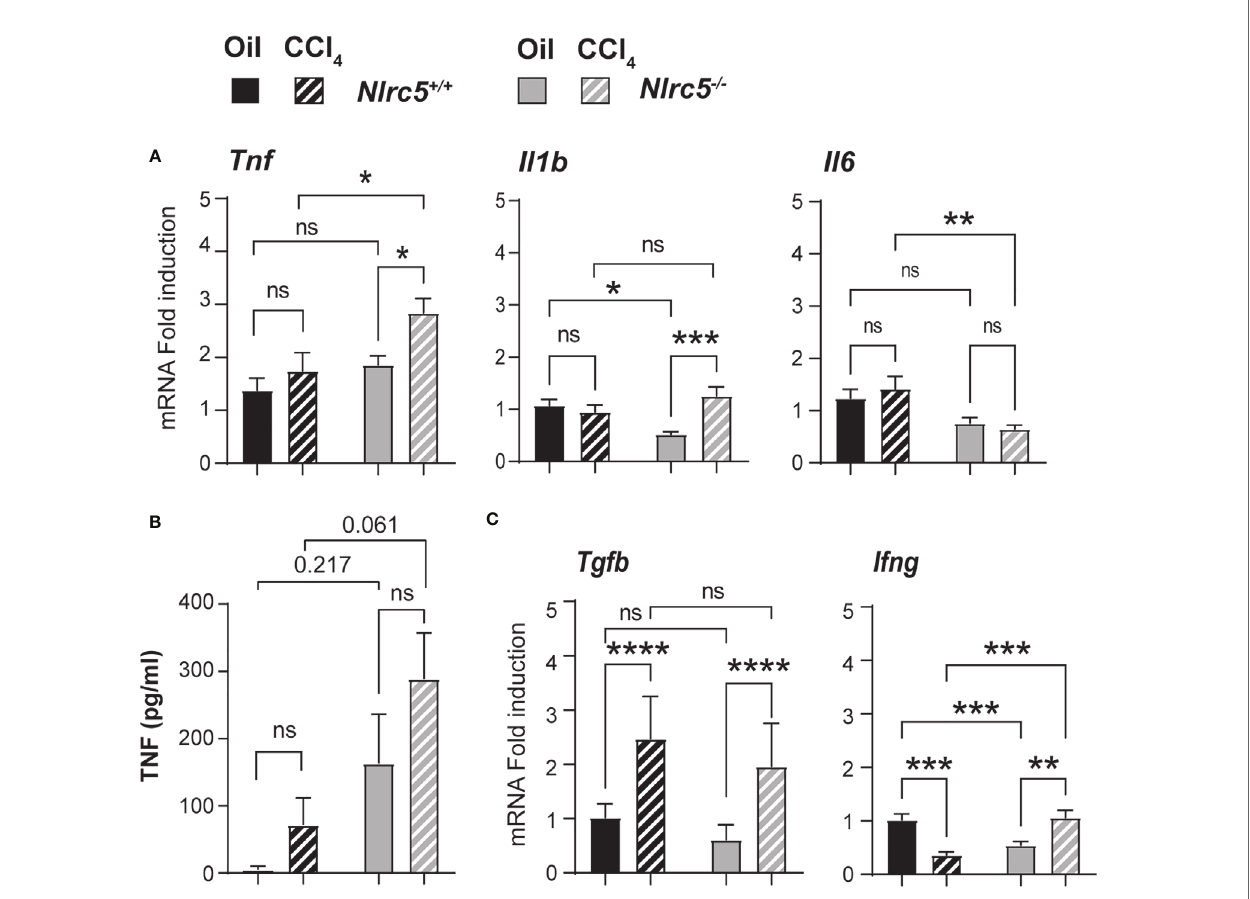
FIGURE 5 | Fibrotic livers of NLRC5-de fi cient mice show increased TNF expression. (A) Hepatic RNA from the indicated groups of mice were tested for the expression of pro-in fl ammatory cytokine genes Tnf, Il1b and Il6 by qRT-PCR; n= 7-11 mice for each group from 2-3 independent experiments. (B) ELISA quanti fi cation of serum TNF levels; n=4 mice per group. (C) Expression of pro- fi brogenic ( Tgfb ) and anti- fi brogenic ( Ifng ) cytokine genes in the liver tissue samples used in (A) . Data shown are mean ± SEM; Two-way ANOVA with Tukey ’ s post-hoc test: *p < 0.05; **p < 0.01; ***p < 0.001; ****p < 0.0001; ns, not signi fi cant. For certain comparisons, signi fi cance values are